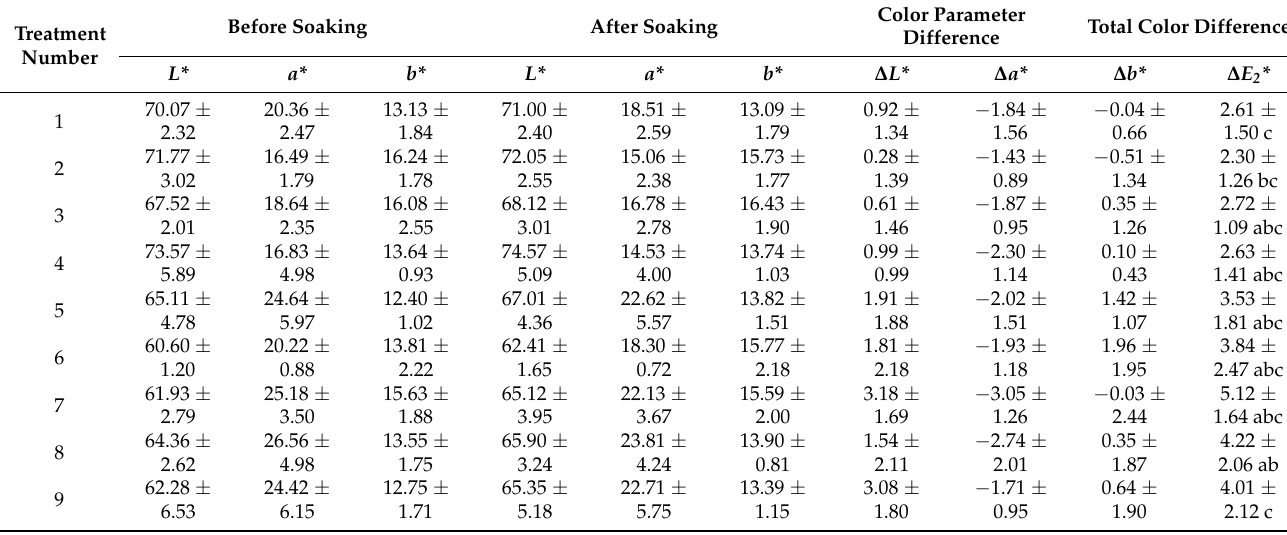
Table 4. Color change of dyed red-heart Chinese fir wood before and after soaking in water for 6 h. Treatment Number